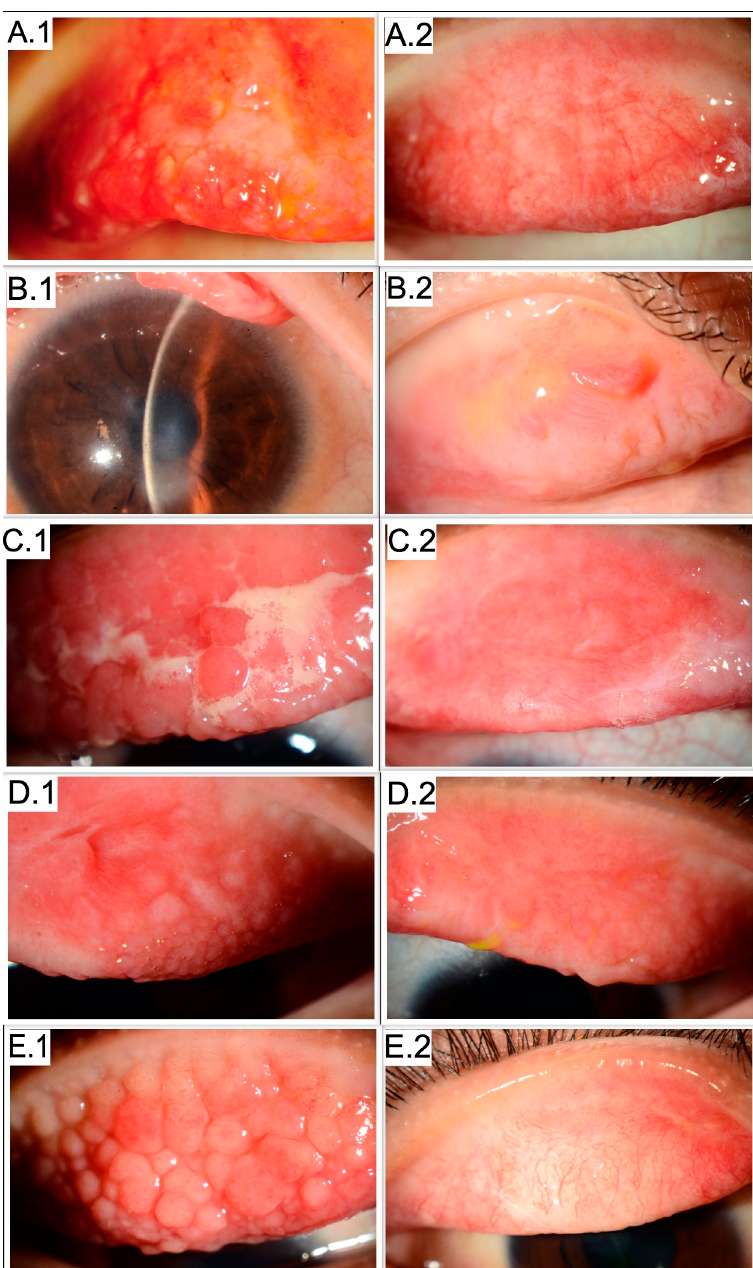
Figure 2. Pre ‐ and Postoperative images of 4 patients (5 eyes) with vernal keratoconjunctivitis ( A.1 ) Preoperative image showing giant papillae on upper tarsal conjunctiva (Case 1) ( A.2 ) Postoperative image 6 weeks after surgery showing scarring of upper tarsal conjunctiva (Case 1) ( B.1 ) Preoperative image showing anterior corneal stromal scarring secondary to previous shield ulcer (Case 2) ( B.2 ) Postoperative image 8 months after surgery showing scarring of upper tarsal conjunctiva (Case 2) ( C.1 ) Preoperative image showing giant papillae on upper tarsal conjunctiva with a mucoid discharge—right eye (Case 3) ( C.2 ) Postoperative image 5 weeks after surgery showing scarring of upper tarsal conjunctiva—right eye (Case 3) ( D.1 ) Preoperative image showing recurrence of giant papillae on upper tarsal conjunctiva and scarring 7 weeks after first surgery—left eye (Case 3) ( D.2 ) Postoperative image 4 months after second surgery showing resolution of giant papillae and scarring of upper tarsal conjunctiva—left eye (Case 3) ( E.1 ) Preoperative image showing giant papillae on upper tarsal conjunctiva (Case 4) ( E.2 ) Postoperative image 6 weeks after surgery showing scarring of upper tarsal conjunctiva (Case 4).